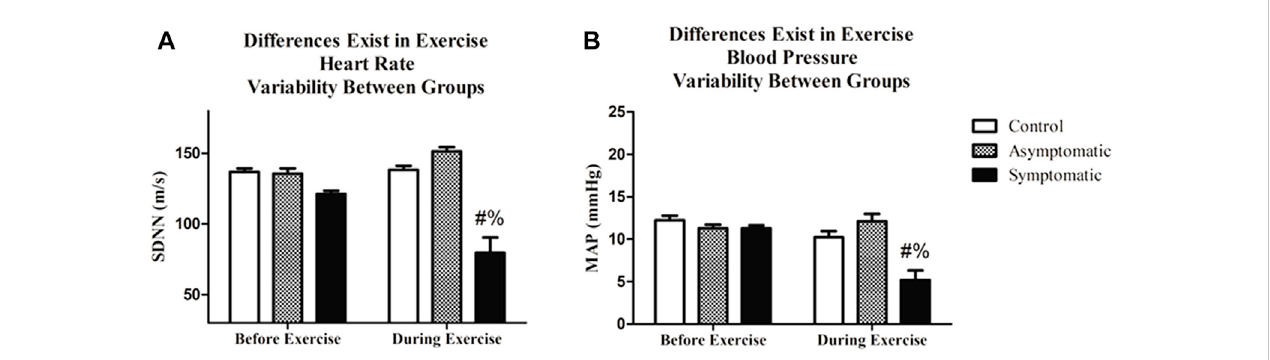
FIGURE 3 Exercise signi fi cantly altered both heart rate variability (HRV) and blood pressure variability (BPV). Additionally, (A) HRV was lower during exercise in COVID-19 symptomatic individuals relative to asymptomatic and control. (B) BPV was different in the symptomatic group during exercise relative to the asymptomatic and control groups. Data analyzed by by a Two-Way Repeated Measures ANOVA with a Bonferroni post-hoc. # = symptomatic vs. control; and=symptomaticvsasymptomatic.Dataarepresentedasmean±SE;HRV=heartratevariability;BPV=bloodpressurevariability.Signi fi cancewasset to p <